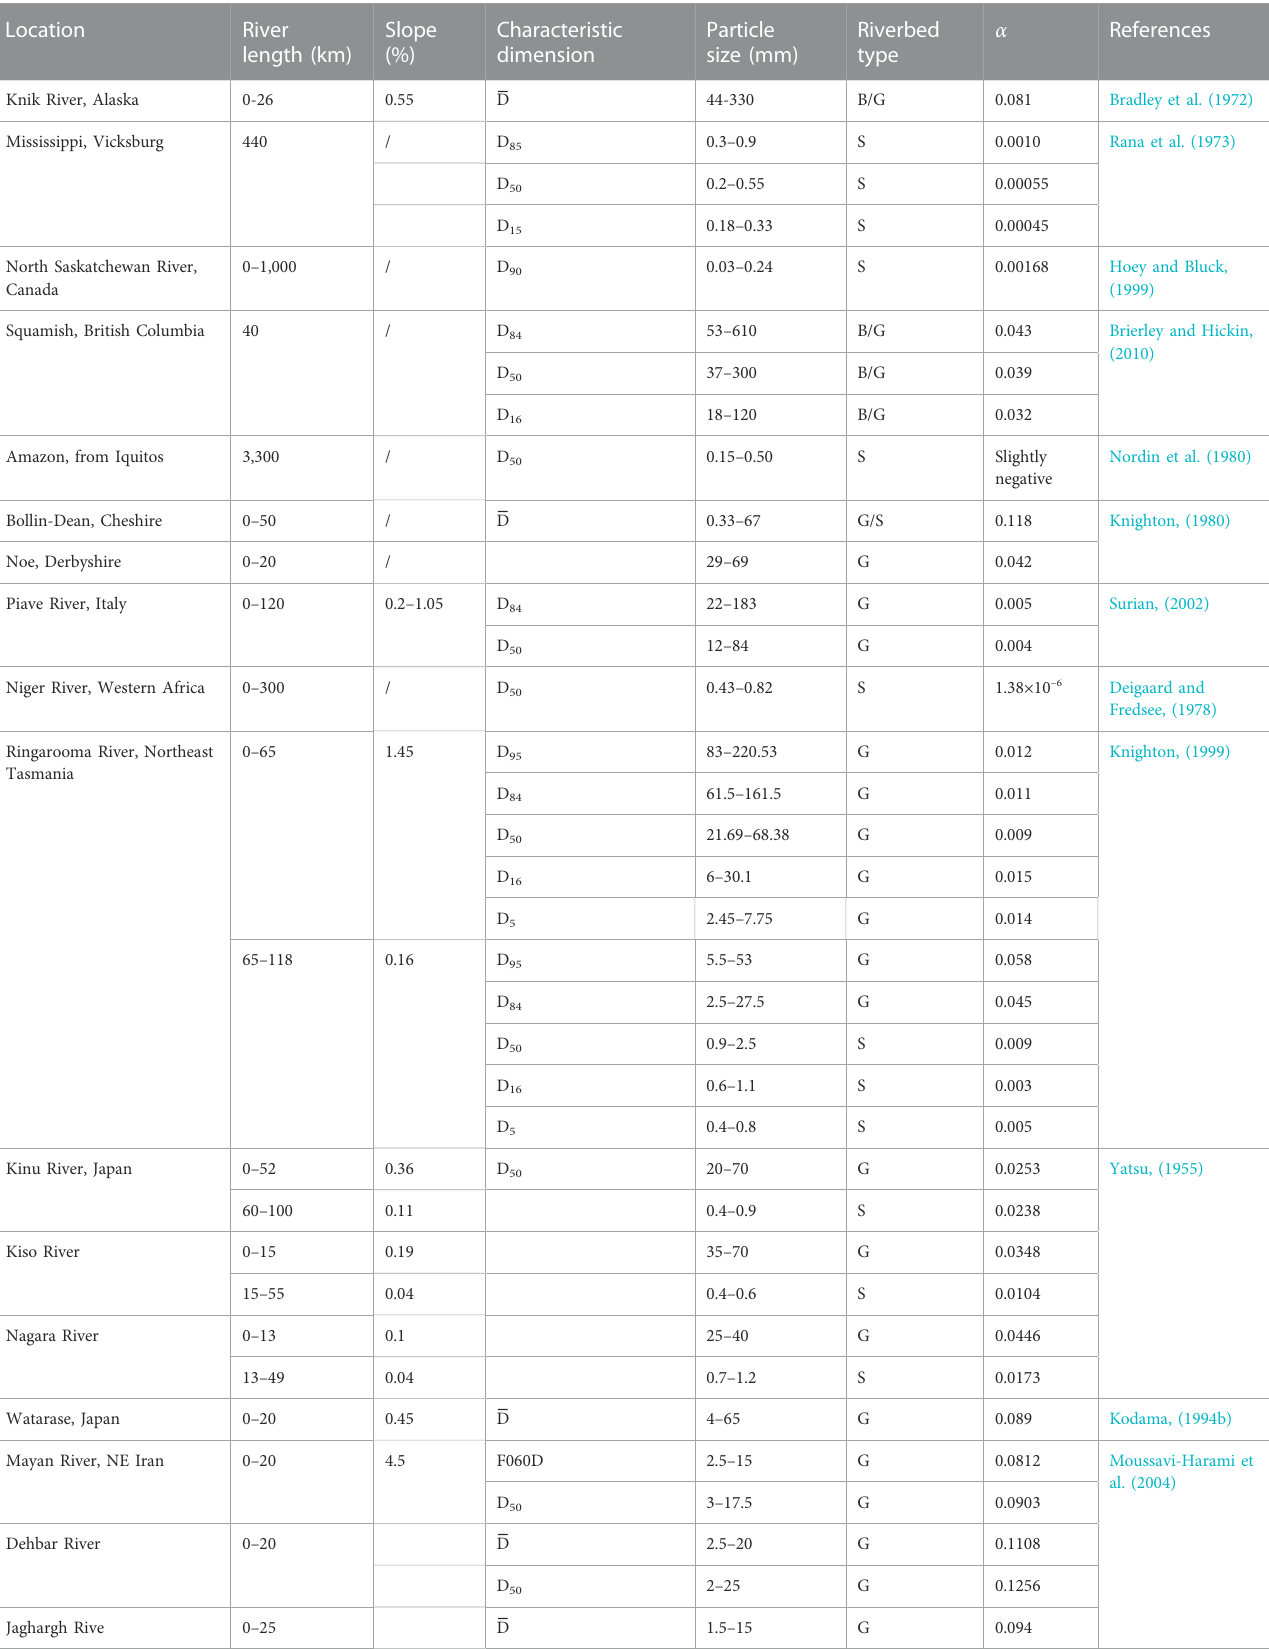
TABLE 1 Fining coef fi cient of clasts in